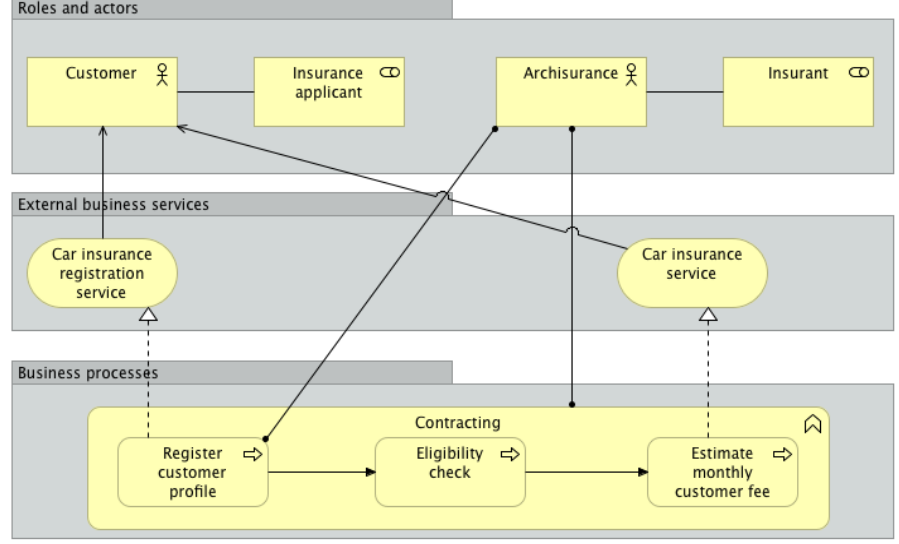
Figure 6. Business Process